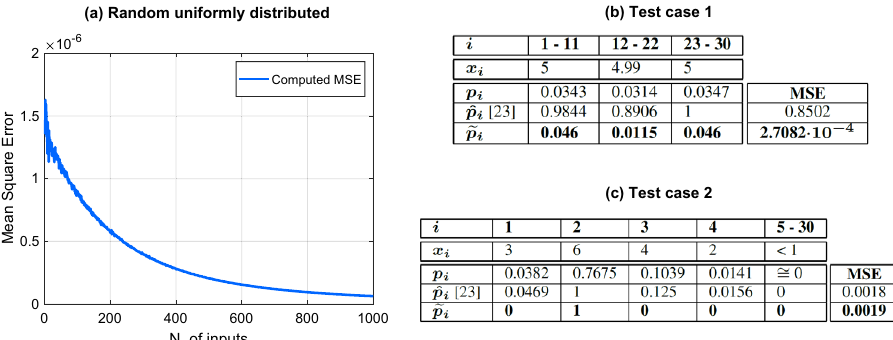
Figure 5. ( a ) MSE of random uniformly distributed inputs vs number of inputs. ( b ) Inputs and outputs for test case n. 1; MSE comparison between 23 and proposed architecture. ( c ) Inputs and outputs for test case n. 2; MSE comparison between 23 and proposed